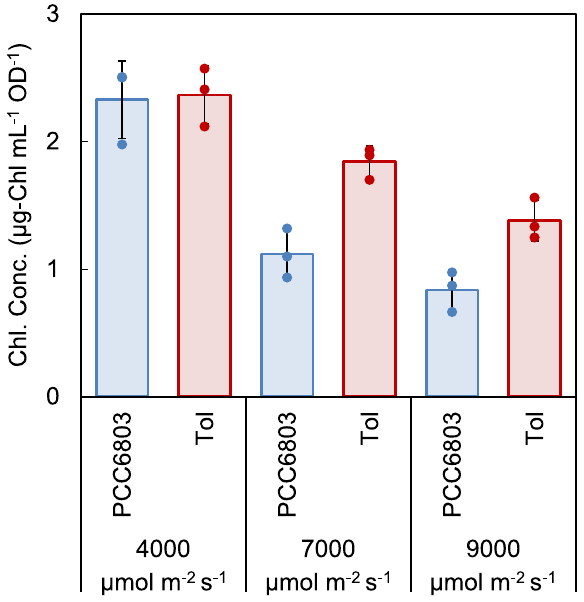
Fig. 3 Chlorophyll content of PCC6803 and Tol strains under different light intensities. The chlorophyll contents were measured at 48 h for all conditions. The bars and plots represent averages and individual data points in the biological triplicate experiments. Error bars indicate standard deviation from the triplicate experiments.